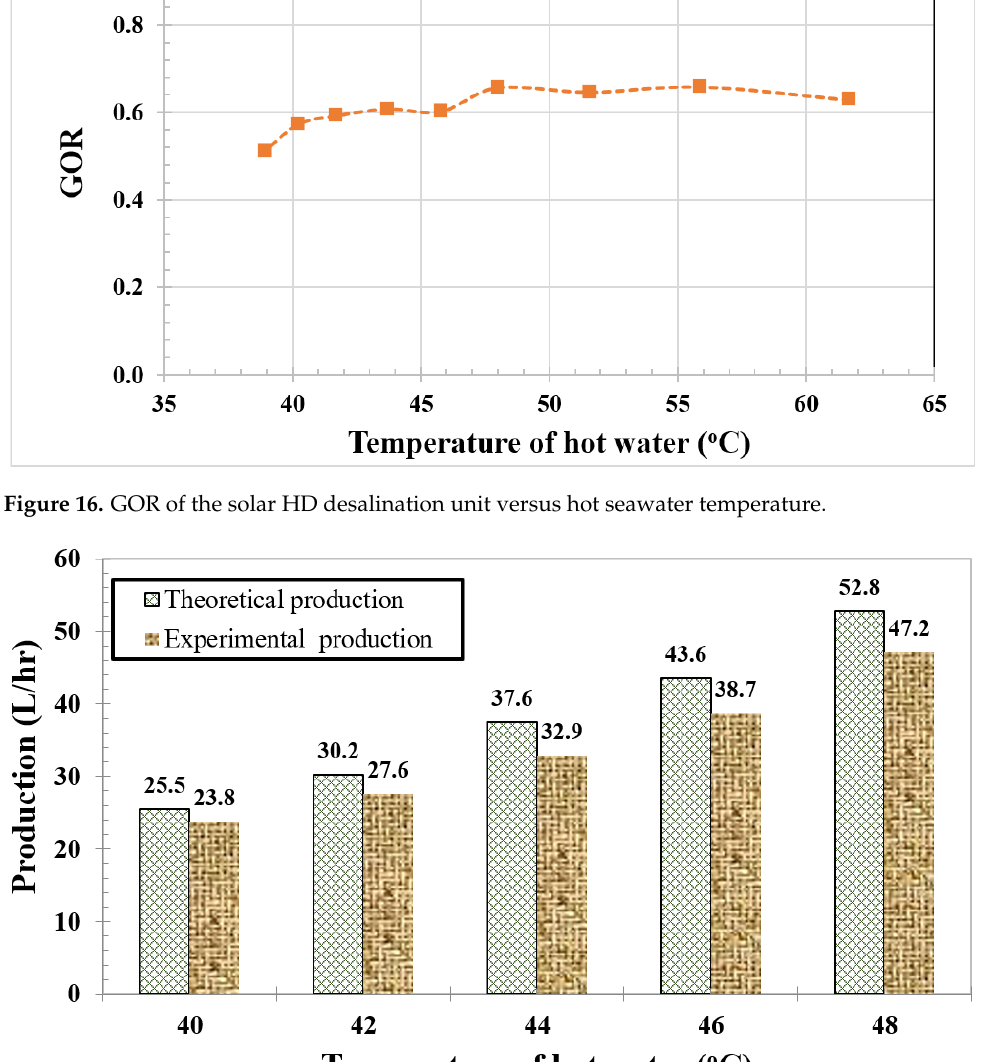
Figure 17. Comparison between expected and experimental freshwater production.